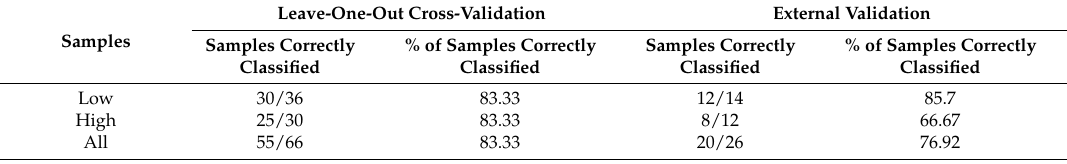
Table 4. Samples correctly classified by the LDA in the leave-one-out cross-validation and in the external validation. The obtained lineal discriminant function is also